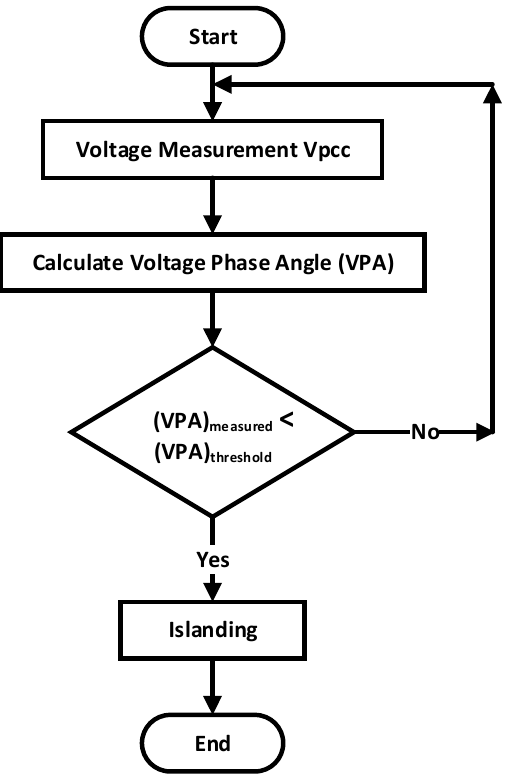
Figure 4. Flowchart of the proposed scheme.